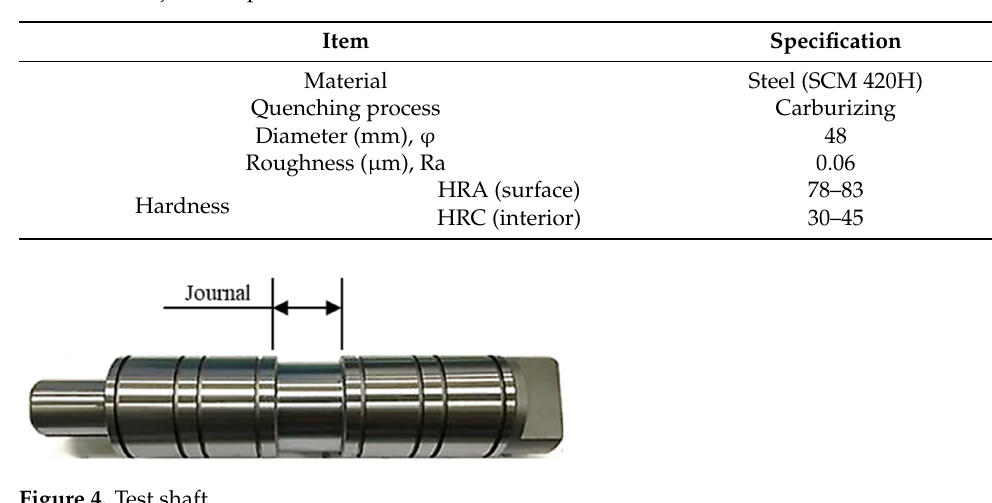
Table 1. Main journal specifications.